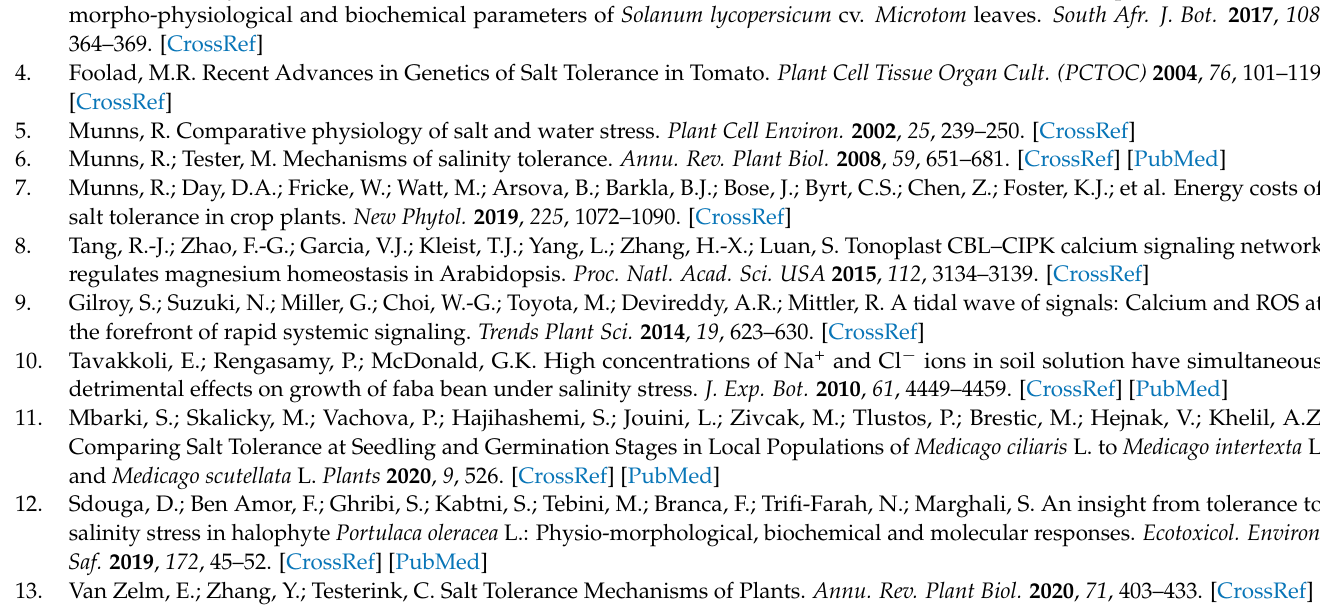
total dry weight. Table S5: Principal component (PC) loadings for salt tolerance index-related traits. Table S6: Individual coordinate PC scores for salt tolerance index-related traits and percent reduction in total dry weight. Figure S1: Effect of salinity on 18 physio-morphological traits. Figure S2: Visual salt damage score for severity of salt susceptibility by on a 1–5 scale. Figure S3: Correlation co-efficient between salt tolerance index-related traits and percent reduction in total dry weight. Figure S4: Individual PCA plot for salt tolerance index-related traits and percent reduction in total dry weight in 27 tomato genotypes at the seedling stage under salinized (200 mM NaCl) and non-salinized conditions during